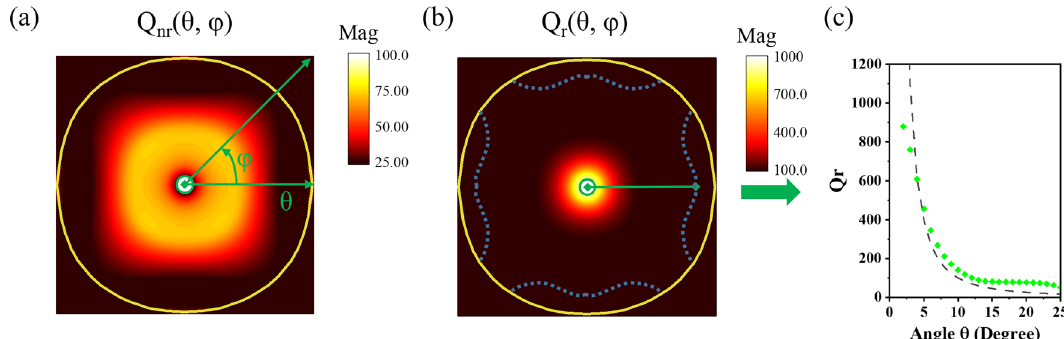
Figure 4. ( a ) Non-radiative Q-factor Q nr map and ( b ) radiative Q-factor Q r map of the DSS at surface Brillouin zone, parametered in polar format with coordinates θ and φ, where Γ point is at the center (green dot) of the map and the radial direction (green arrow) away from the center represents the angle θ increasing from 2° (small green circle) to the angular position of the bulk band projection. For reference, the yellow loops denote the angular position of the NC projection, and the dot lines in ( b ) label the angular positions where the DSS meets the edge of the bulk band. ( c ) Q r versus θ along ГX direction (φ = 0), as denoted by the green line section in ( b ). The symbols are the numerically obtained Q r , and the dash line represents the function plot 1 / sin 2 θ